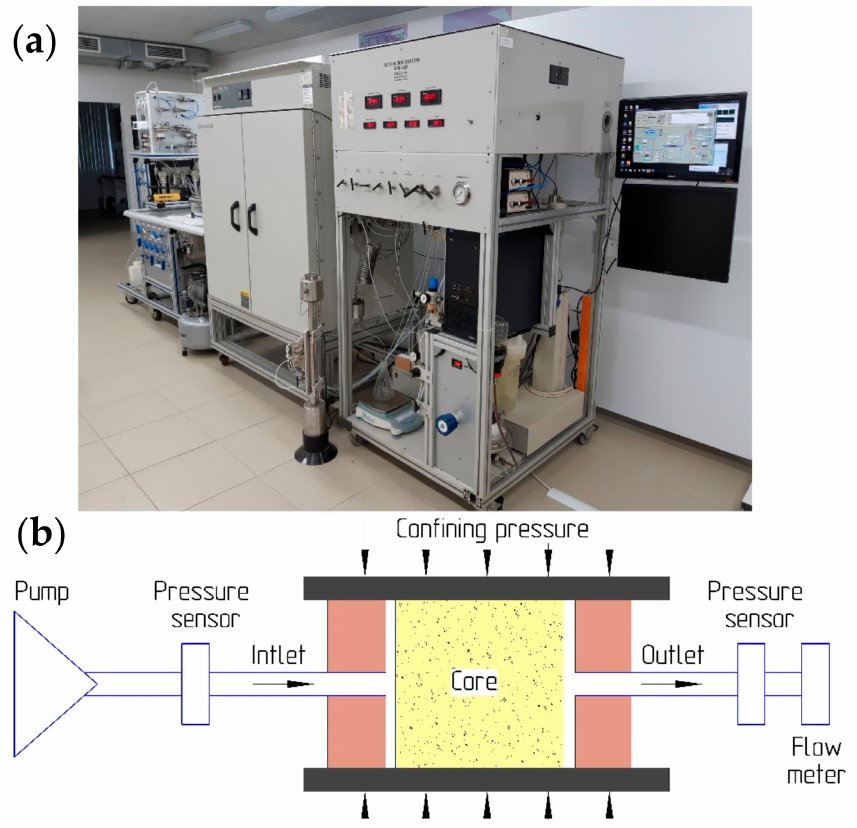
Figure 3. Photo ( a ) and schematic diagram ( b ) of the unit for